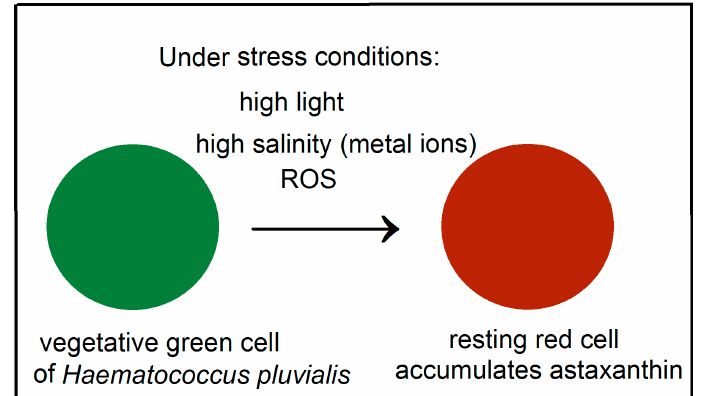
Figure 1. Schematic diagram of astaxanthin’s accumulation in H. pluvialis alga under stress conditions. The high amount of astaxanthin present in the resting cells is rapidly accumulated when the environmental conditions become unfavorable for normal cell growth.